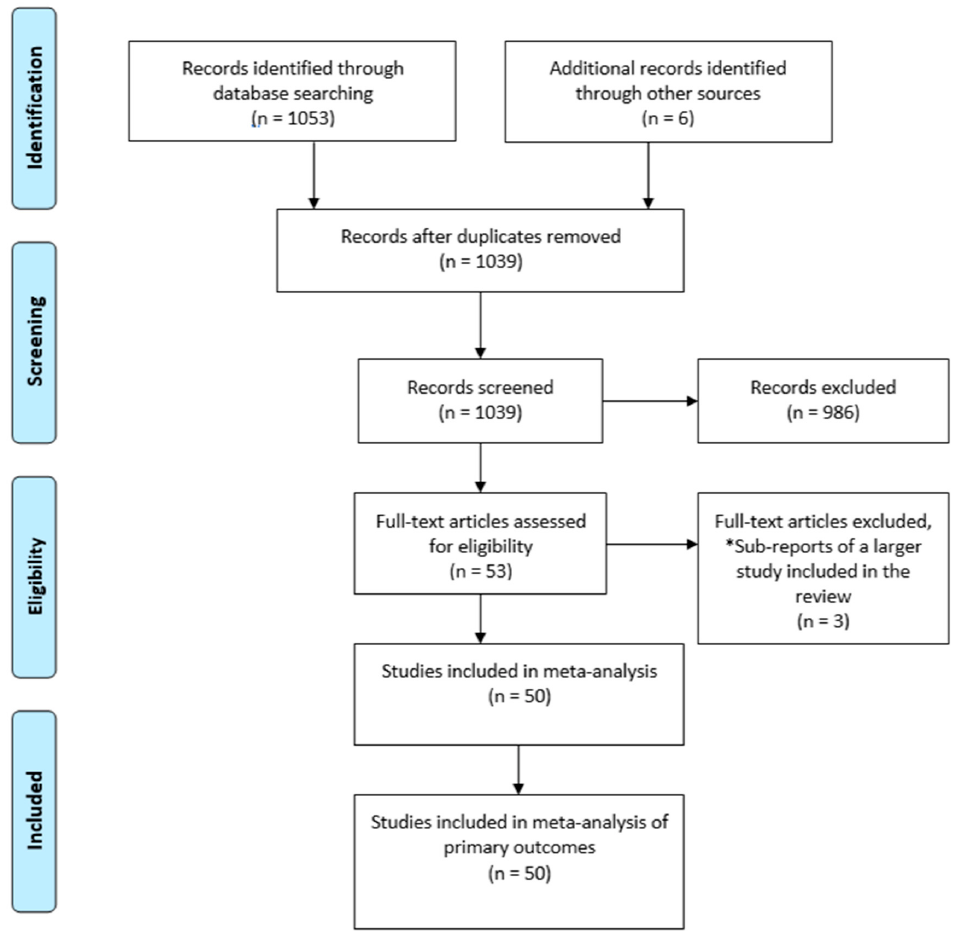
Figure 1. Preferred reporting items for systematic reviews and meta-analysis (PRISMA) flow diagram.